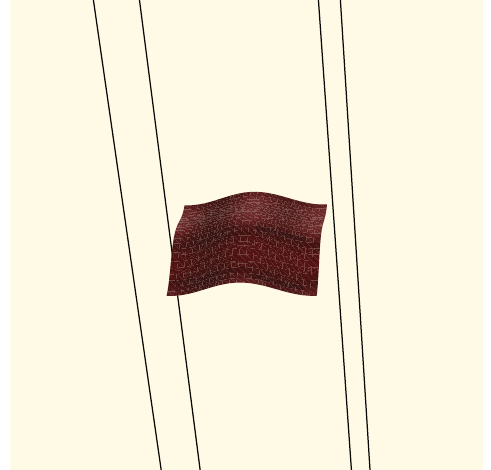
Figure 2: Plot of the interface between the heavy (above) and light (below) fl uids at initial time for Rayleigh-Taylor fl uid instability. For this study, density ratio is 2:1, the Atwood number is 1/3, the peak to peak amplitude of initial disturbance is 0.06, grid size is 20 × 20 × 200 , and computational domain is 1 cm × 1cm × 10 cm